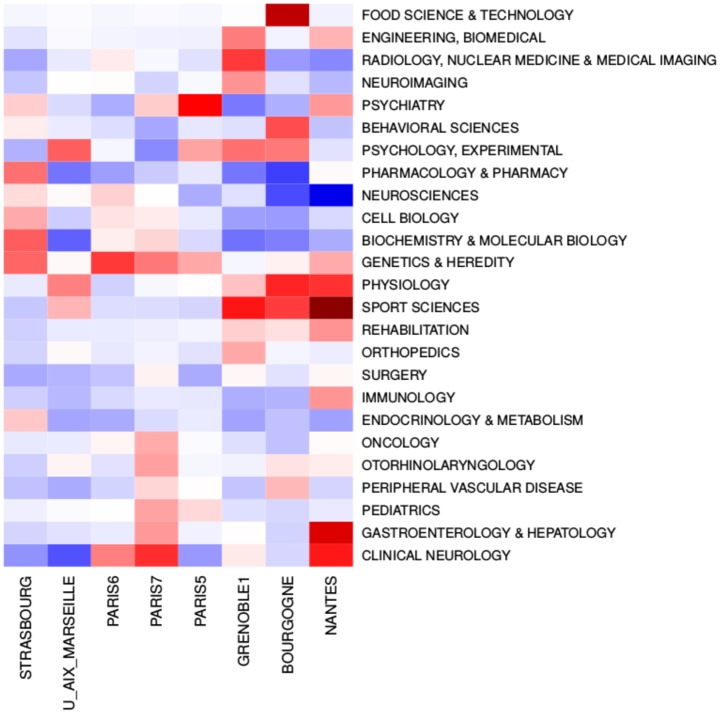
Comparison of category contributions for 8 universities.Red cells correspond to positive values of the centred contributions, while blue cells correspond to negative values. White cells correspond to contributions with p-values larger than 0.1. Categories are displayed only if the centred contribution is greater than 0.5 or smaller than -0.5 for at least one of the eight universities. Data in data_integer/stat_results files in https://github.com/turckheim/interdisciplinarity.